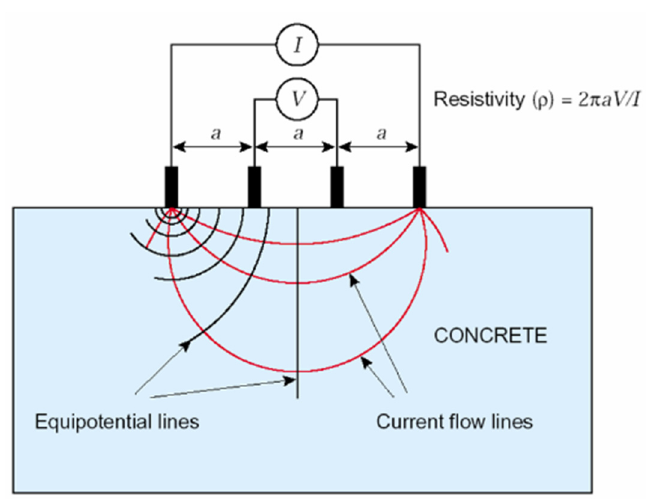
Figure 3. Measurement of the electrical resistivity measurements in concrete.